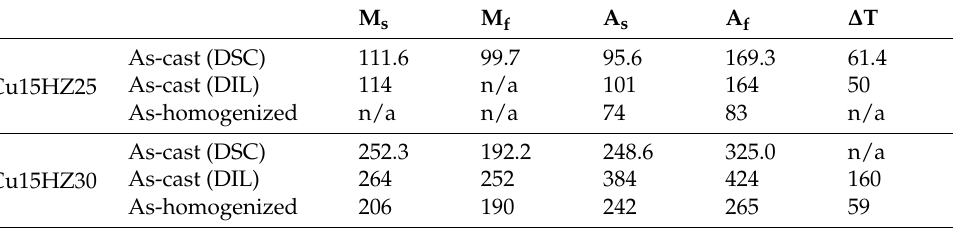
Figure 3. Thermal analysis of as-cast and as-homogenized states. ( a ) Cu15HZ25 and ( b ) Cu15HZ30, analyzed by DSC; ( c ) Cu15HZ25 and ( d ) Cu15HZ30, analyzed by DIL. Table 2. Phase transformation temperatures for Cu15HZ25 and Cu15HZ30 in as-cast and as-homogenized states.